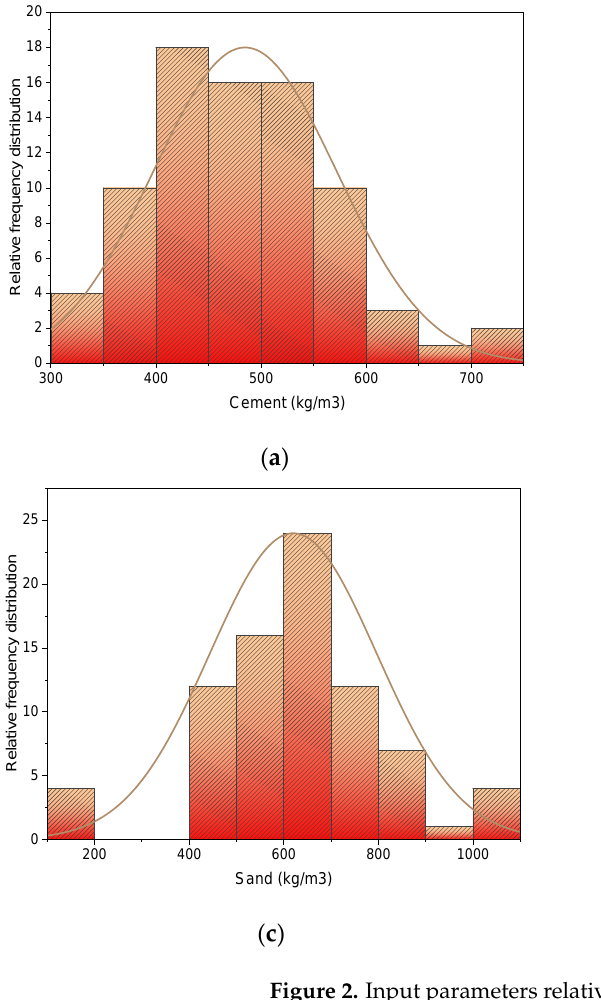
Table 5. Input and output variables range.